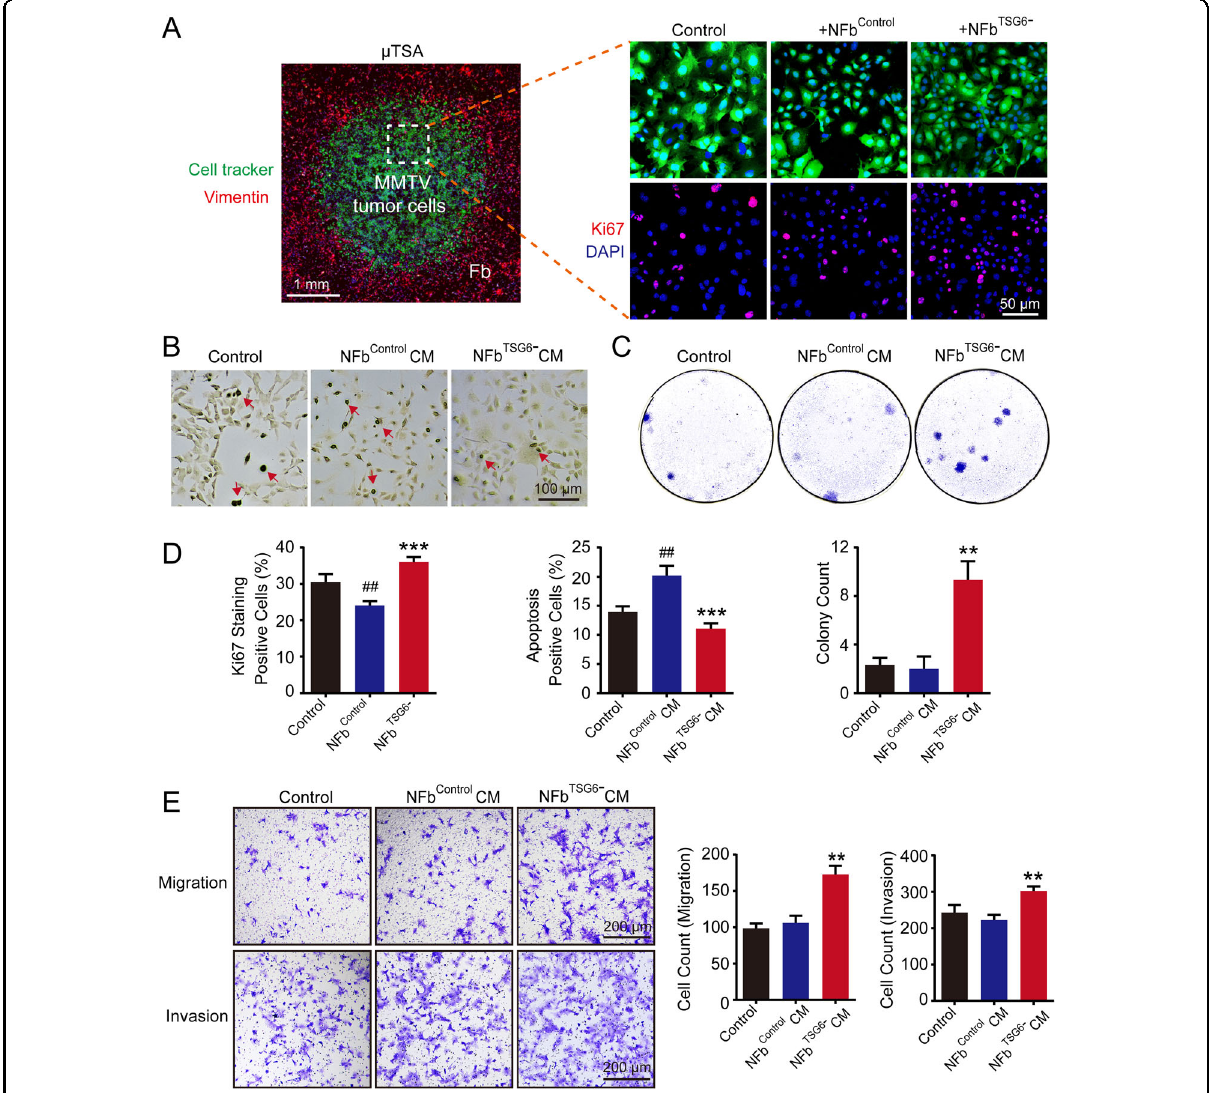
Fig. 3 Disorganization of HA cross-linking in normal fi broblasts promoted breast cancer malignancy. A Primary tumor cells from MMTV-PyMT mice were stained with cell tracker (green) and then co-cultured with or without corresponding normal fi broblasts (NFb Control and NFb TSG6 − ) in the tumor – stromal assay (TSA). As shown in the left image, tumor cells (green) were in the middle of TSA and surrounded by fi broblasts (red, illustrated by staining vimentin). After 72 h, the proliferation of tumor cells was determined by staining Ki67. The top panel shows the representative images of tumor cells (green) with nuclei (DAPI). The down panel shows the Ki67 expression (red) in corresponding nuclei. B After stimulation with 50% conditioned media (CM) of NFb Control or NFb TSG6 − , the apoptosis of tumor cells was evaluated by the TdT-DAB apoptosis assay. Red arrows indicate the apoptotic tumor cells. C The colony formation abilities of tumor cells treated with NFb Control CM or NFb TSG6 − CM. D The statistical histograms of Ki67 percentage, apoptotic percentage, and colony count of tumor cells in different groups. E The migration and invasion abilities of tumor cells. All experiments were repeated three times with similar results. Error bars represent mean ± SD values. Statistical analysis was performed using Student ’ s t test. ** p < 0.01, *** p < 0.001 (vs NFb Control or NFb Control CM), ## p < 0.01 (vs